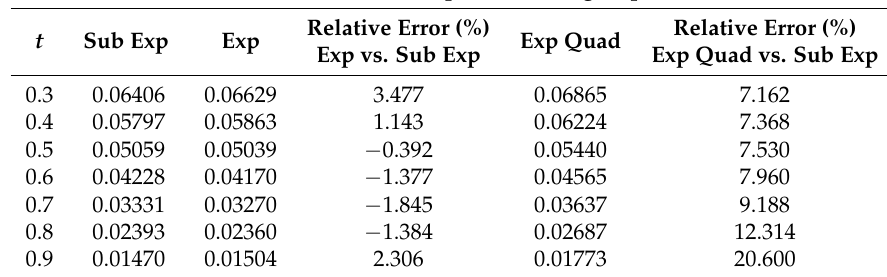
( 2 ) : Silver, S : gold. d = 3. Option payoff: ( β 1 G t